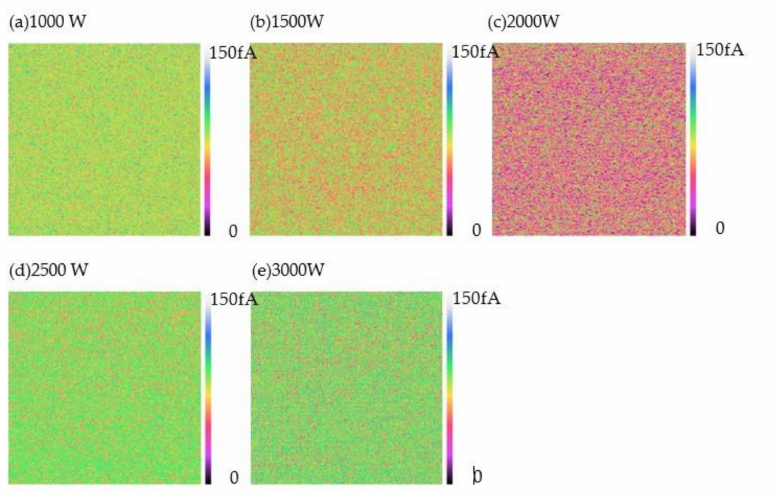
Figure 7. CAFM images of the RP-ALD SiO 2 thin films with different powers ( a ) 1000 W, ( b ) 1500 W, ( c ) 2000 W, ( d ) 2500 W and ( e ) 3000